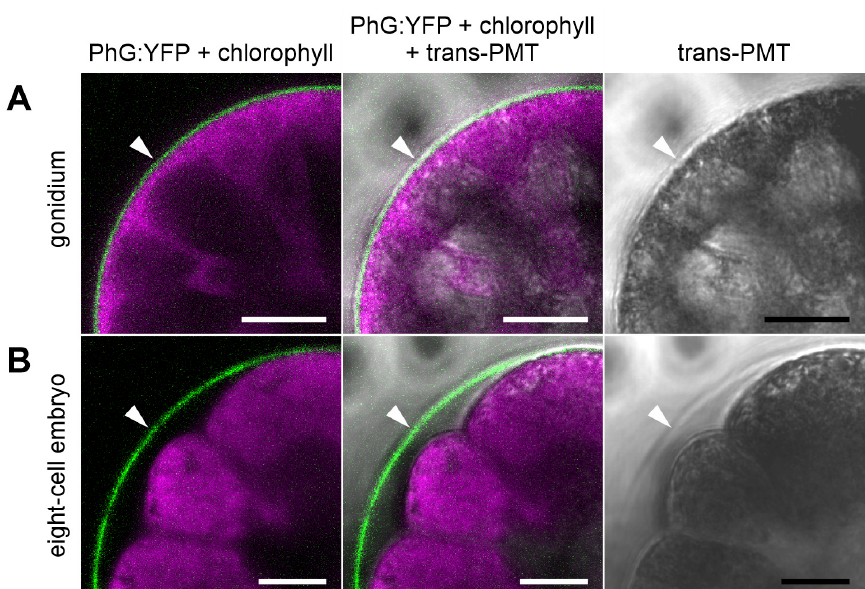
Figure 6. Closer examination of the distance between the PhG:YFP-stained gonidial vesicle (CZ1) and enclosed cells. Transformants expressing the phG : yfp gene were analyzed in vivo at different developmental stages for the localization of the PHG:YFP fusion protein and the relative position of the enclosed cells. High-magnification CLSM optical cross-sections focusing on the gonidial vesicle (arrowhead) and the cell borders. Transmission-PMT (trans-PMT) images are included for orientation. ( A ) Mature gonidium shortly before the first cell division. There is no detectable space between the gonidial vesicle and the plasma membrane of the gonidium. ( B ) Embryo at the eight-cell stage. The dividing cells detach in the most places from the surrounding gonidial vesicle. The distance between the gonidial vesicle and the plasma membrane of the cells is up to 8 μ m. Column 1: Overlay of YFP fluorescence of PhG:YFP protein (green) and chlorophyll fluorescence (magenta). Column 2: Overlay of PhG:YFP fluorescence (green), chlorophyll fluorescence (magenta) and transmission-PMT (trans-PMT). Column 3: Transmission-PMT alone. Scale bars: 12.5 μ m.